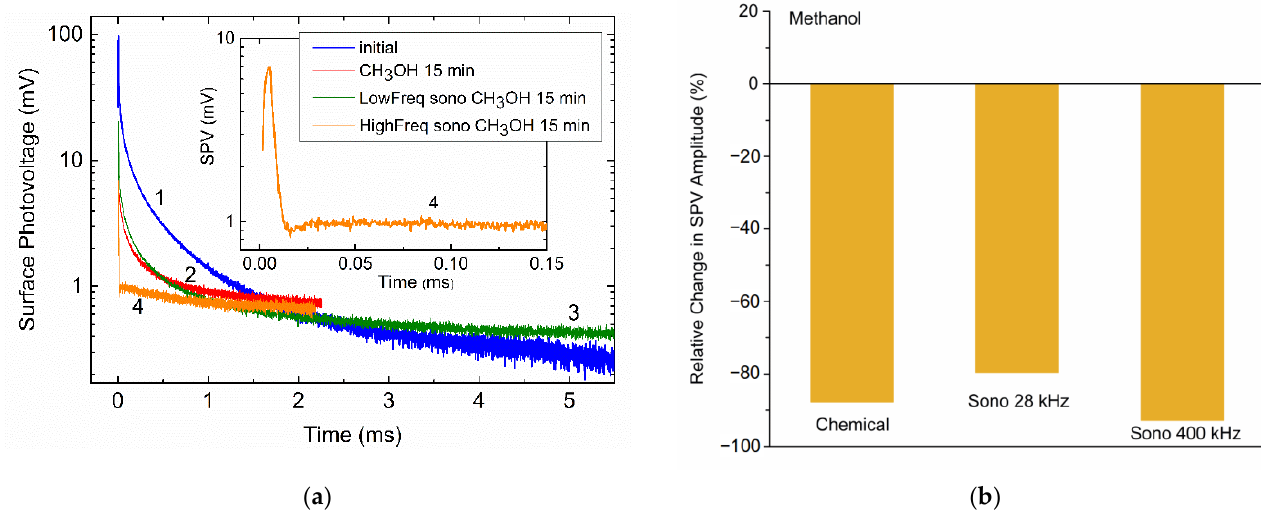
Figure 9. ( a ) Time-dependent SPV of Si samples before (curve 1) and after chemical (curve 2) and sonochemical treatments at about 28 (curve 3) and 400 kHz (curve 4) in methanol; ( b ) relative change in the SPV amplitudes due to exposure of Si to methanol and sonication in methanol at about 28 and 400 kHz. The data in ( b ) are obtained from decays shown in ( a ) at time moment 𝑡 = 0.